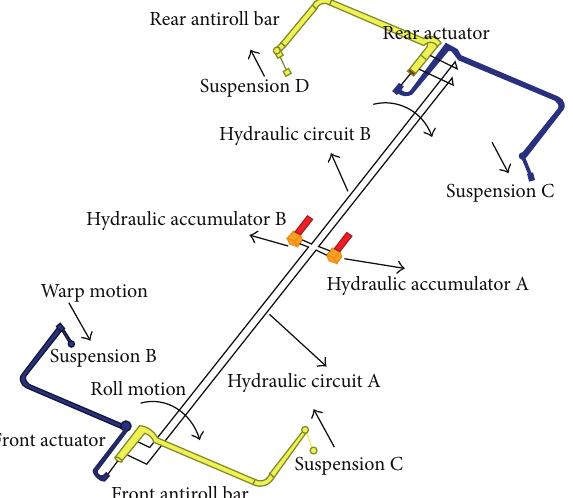
Figure 4: Three-dimensional diagram of a KDS system.